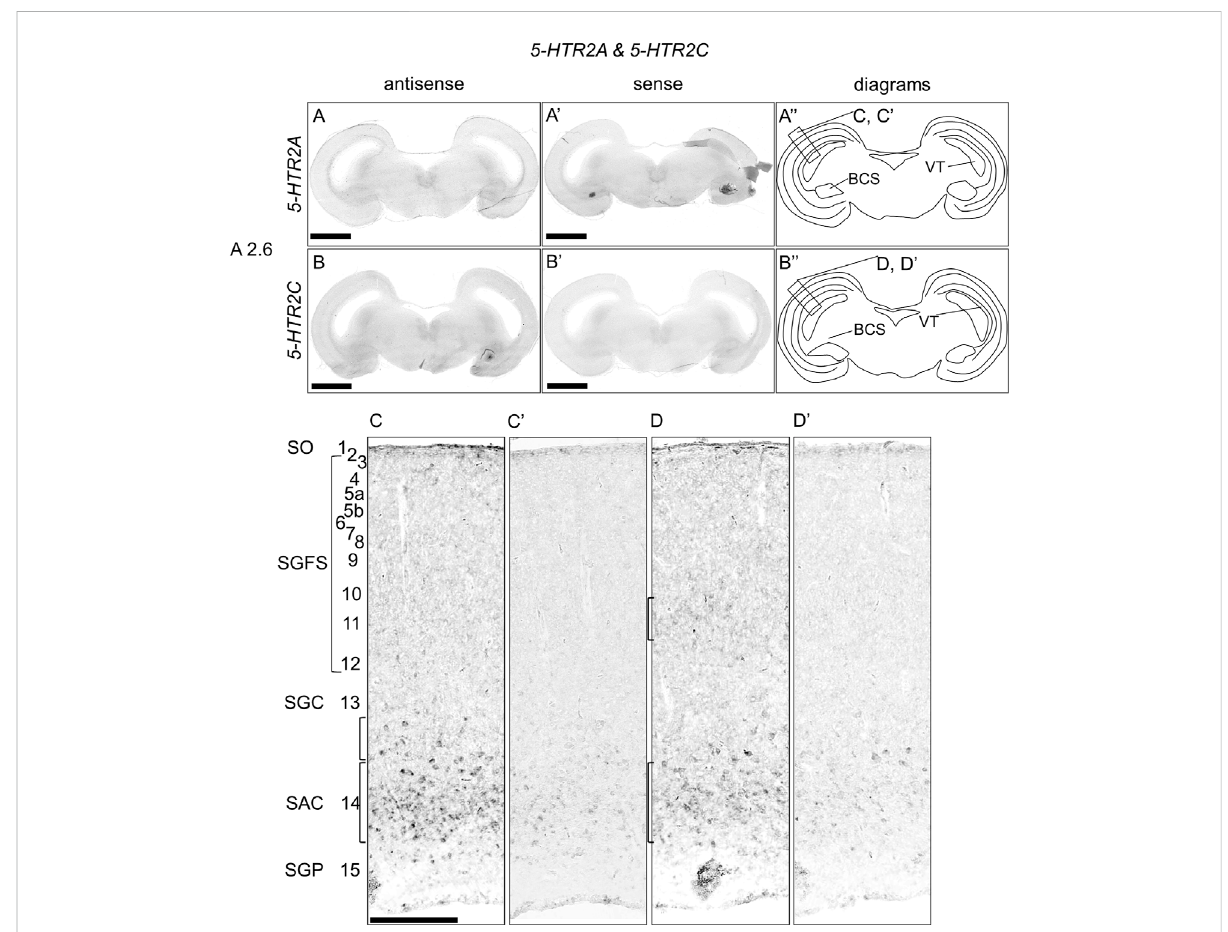
FIGURE 5 In situ hybridization of 5-HTR2A and 5-HTR2C in the P1 chick brainstem. Digoxigenin-labeled RNA antisense [ 5-HTR2A , (A,C) , and 5-HTR2C, (B,D) ] and sense [ 5-HTR2A , (A 9 ,C 9 ) , and 5-HTR2C, (B 9 ,D 9 ) ] probes were used for in situ hybridization in coronal sections of P1 chick brainstems. To evaluate the expression patterns of 5-HTR2A and 5-HTR2C , we analyzed sections from four chick brainstems for 5-HTR2A and 4 for 5-HTR2C